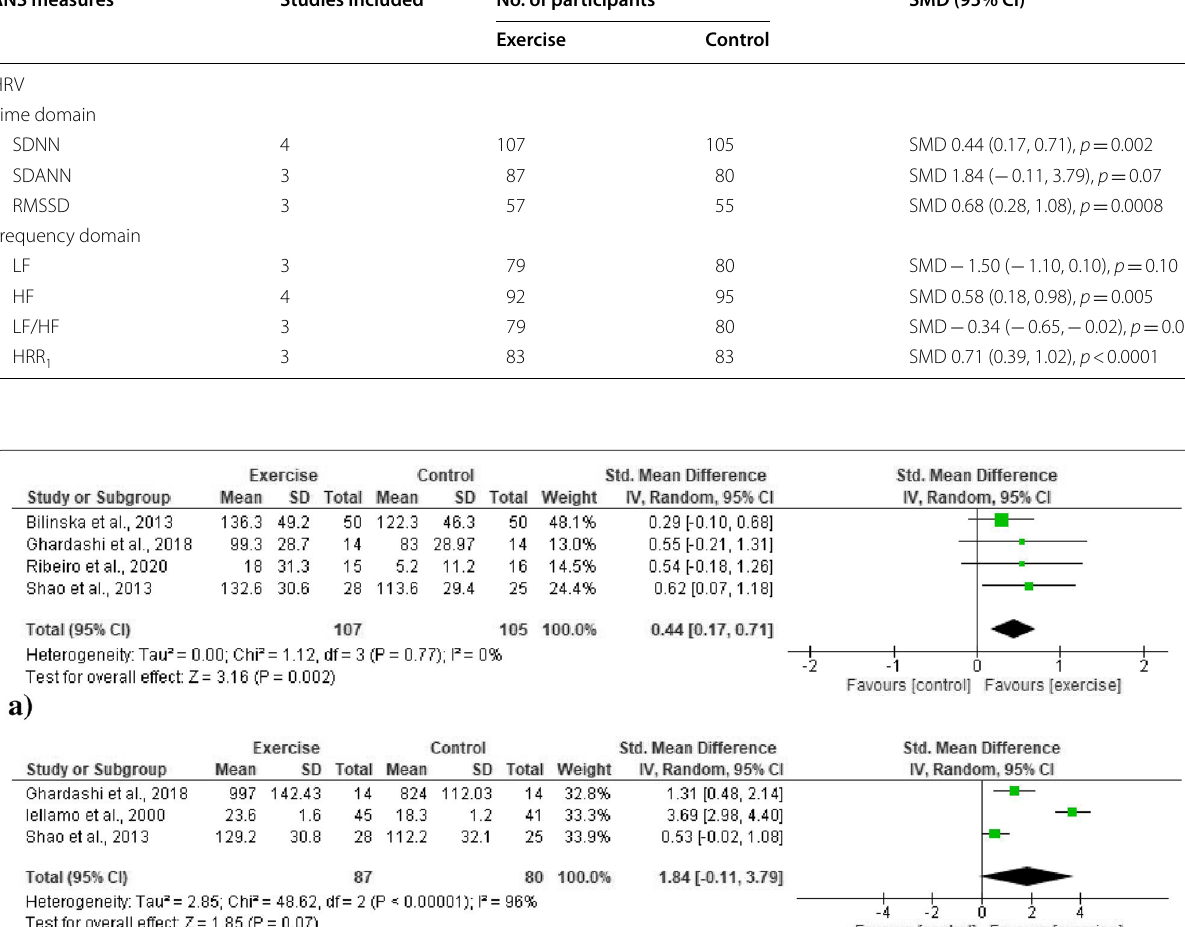
Table 2 An outline of all pooled data analysis for HRV and HRR measures ANS measures